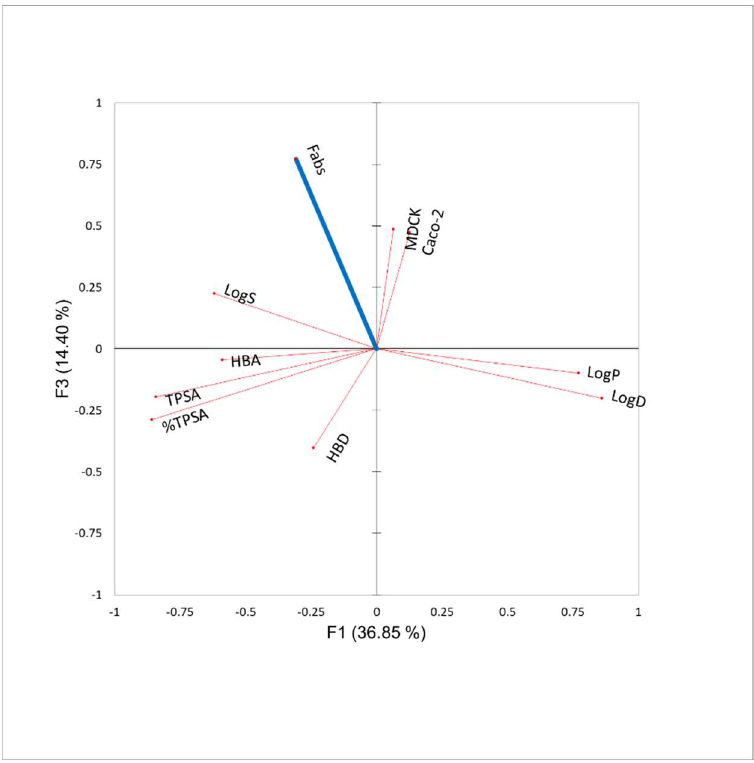
Figure 1. Ordination biplots of principal component analysis (PCA) outputs of the physicochemical space in a series of oral targeted anticancer drugs (n = 28).